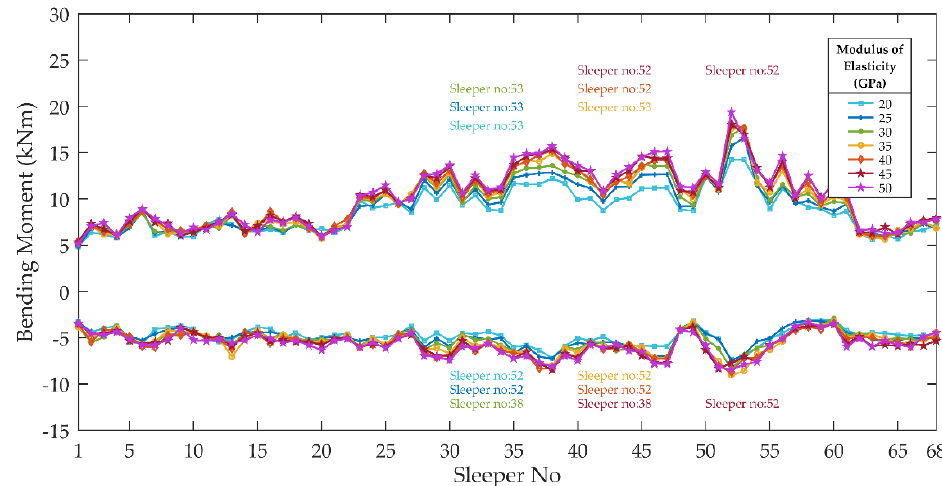
Figure 13. Longitudinal bending moment distribution with reference to various moduli of elasticity.